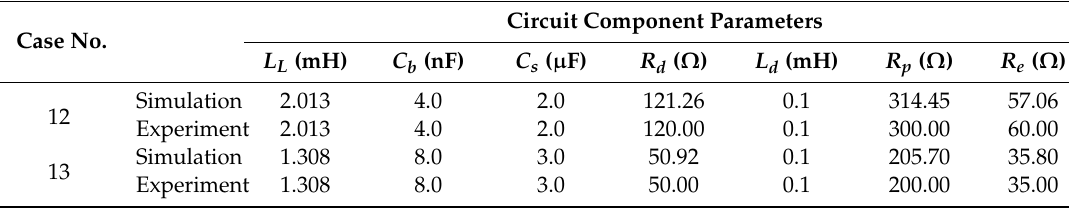
Table 8. Circuit component parameters of the generated waveforms in the example cases.